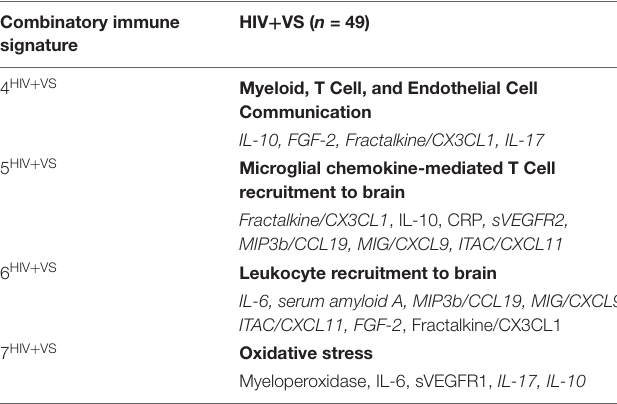
TABLE 3 | Strongest network of inflammatory markers contributing to Combinatory Immune Signatures that were specific to HIV-uninfected (HIV − ) women.